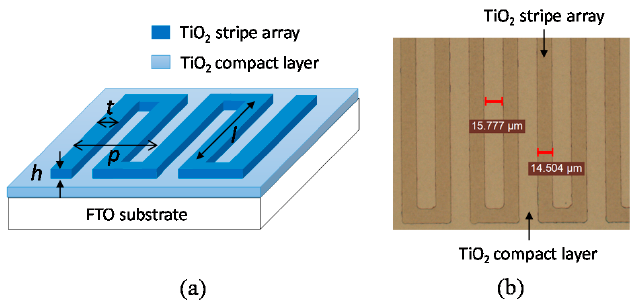
Figure 1. ( a ) Design and ( b ) optical microscope image of the TiO 2 stripe array.